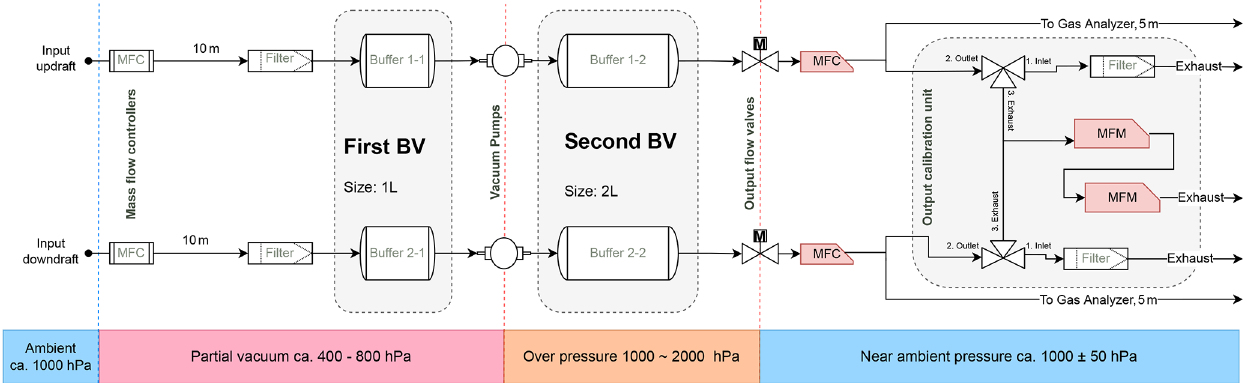
Figure 4. Functional and pneumatic schematic of the implemented flow-through STEA system showing components, layout, properties, and operation conditions. Air samples are collected at the input and travel in distinct sampling lines for updrafts and downdrafts. Samples travel through tubes (lengths are shown) and through filters and are then collected into two sets of buffer volumes shown here as “first BV” and “second BV” separated by two vacuum pumps. The “output flow valves” followed by mass flow controllers (MFCs) control the output flow rate from the second set of buffers to the gas analyzers. Finally, samples can optionally be forwarded to a set of mass flowmeters (MFMs) used for calibration purposes. The colored bottom bar below shows the range of pressure values at each